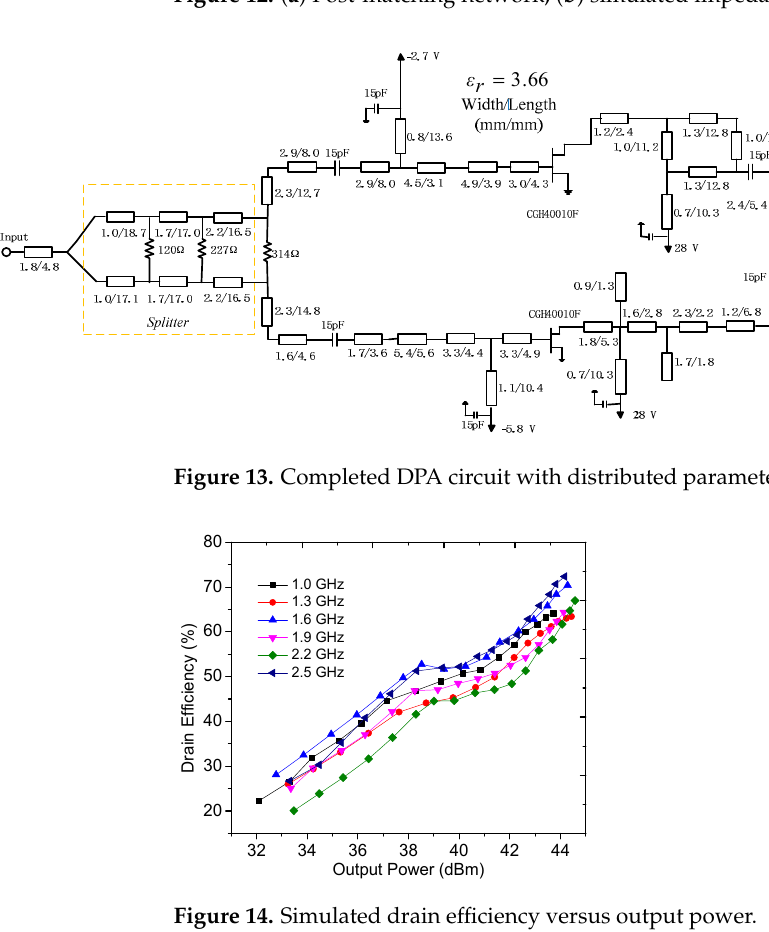
( b ) Figure 15. Trajectories of impedance Z M and Z A at several representative frequencies: ( a ) impedance Z M ; ( b ) impedance Z A . 4. Experiment and Results Analysis A DPA circuit was fabricated using Rogers 4350B ( ε r = 3.66, H = 20 mils) substrate based on the schematic shown in Figure 13. Figure 16 shows a photograph of the fabri- cated DPA. The overall size of the circuit is 11.2 cm × 5.3 cm. 5.3cm